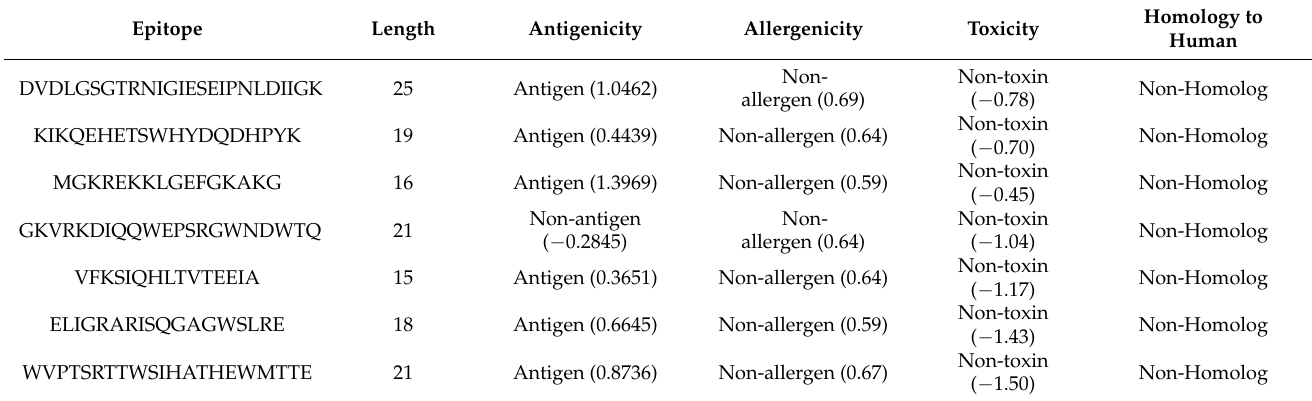
Table 4. Predicted results of the immunological properties of the epitopes as vaccine candidates. The values are enclosed in brackets.